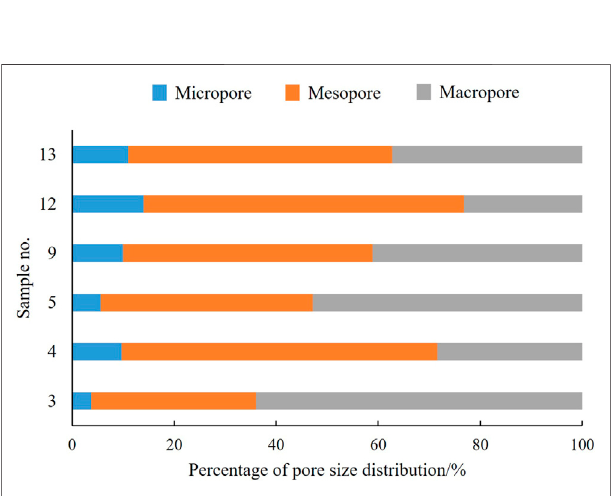
FIGURE 9 | Pore size distribution characteristics of continental shale in northeastern Sichuan Basin.